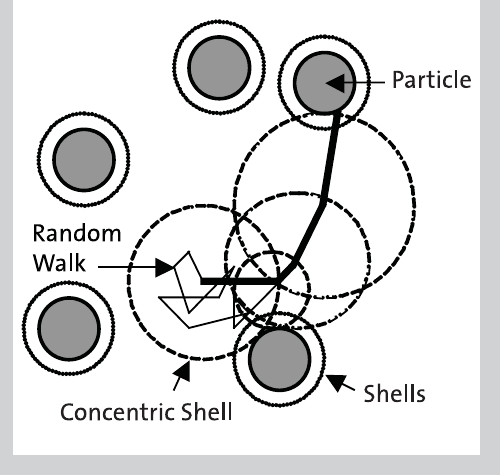
Figure 1: Two-dimensional schematic representation of the method used by Torquato and Kim [6], leading to a more efficient simulation of random walk. Figure 2: The figure shows the two thin shells, constructed for the purpose of the simula- tion, around each spherical filler domain. When the tracer particle gets closer than a distance d to the sur- face of a filler phase, it is removed and placed ran- domly on a point on the shell S, at a distance a (a = S + d ) away from the surface of that filler particle. The average time for this process to occur is given by Eg. 8, when the diffusion of tracer particles is consider- ably faster on the filler than it is in the matrix